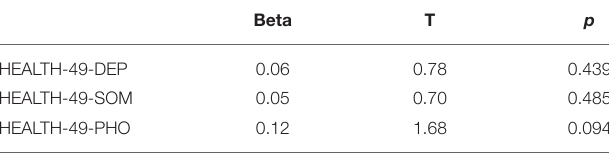
TABLE 6 | Multiple regression for prediction of